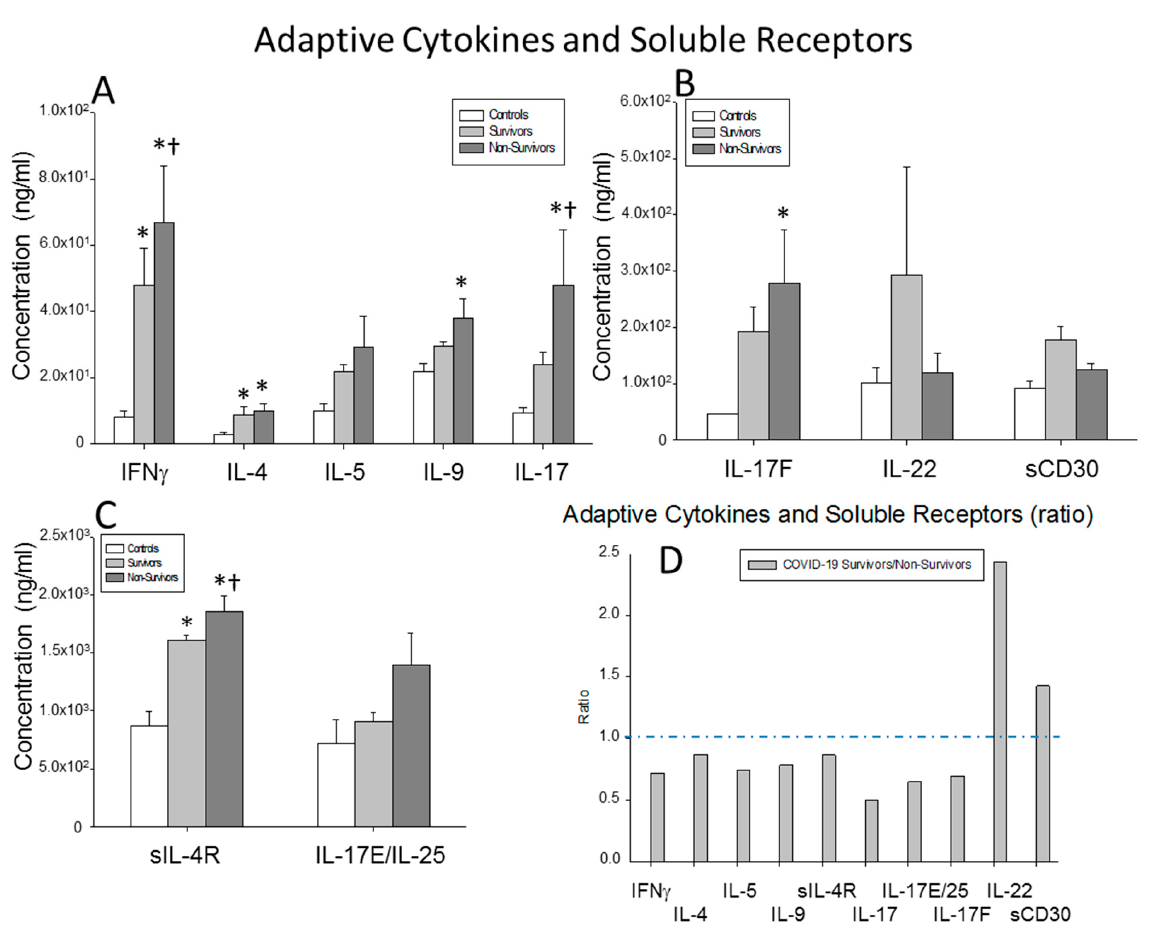
Figure 5. Adaptive cytokine results. ( A – C ) Data represent the concentrations of the cytokines and soluble receptors indicated for ( ) surviving COVID-19 patients, ( ) non-surviving COVID-19 patients and ( ) healthy controls. All the values are expressed as the means ± S.E.M.s *, p < 0.05 for surviving or non-surviving COVID-19 patients versus healthy controls. †, p < 0.05 for surviving versus non-surviving COVID-19 patients. ( D ) Data represent the ratios between circulating levels of surviving and non-surviving COVID-19 patients. The dotted line represents a reference line for the ratio equal to 1 between survivors and non-survivors